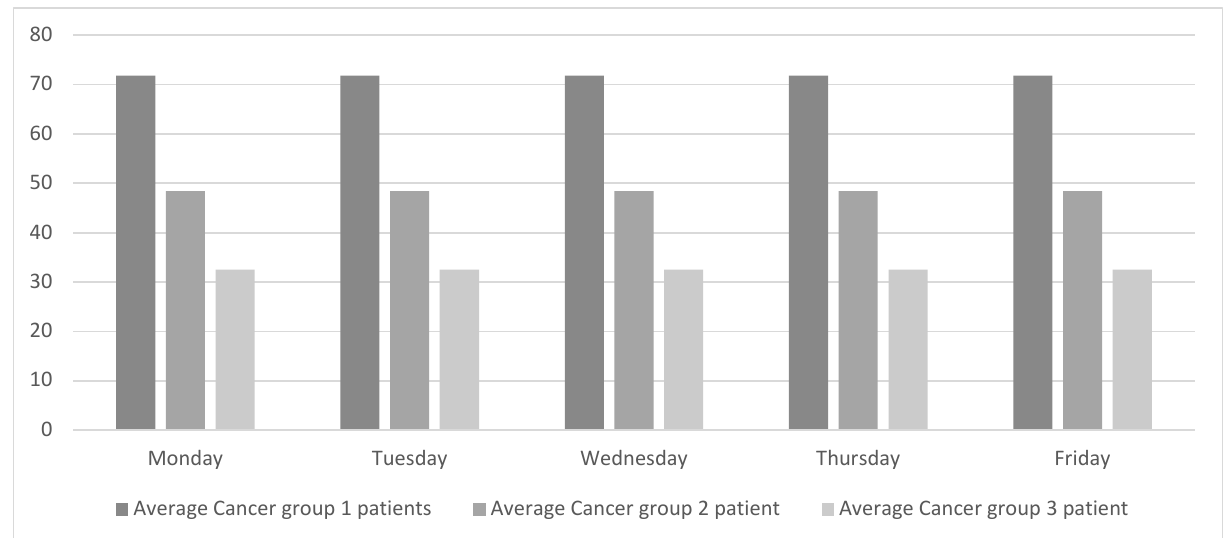
Figure 4. Proposed daily patients’ average per specialty.